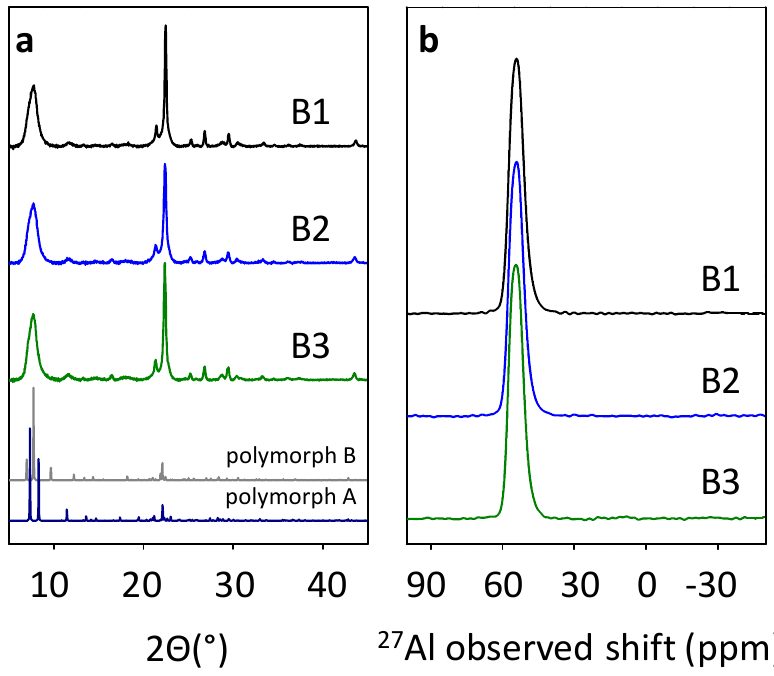
Figure 1. X-ray di ff raction patterns of as-synthesized B1–B3 samples together with *BEA polymorphs Figure 1. X ‐ ray diffraction patterns of as ‐ synthesized B1–B3 samples together with *BEA polymorphs A and B ( a ) and 27 Al MAS NMR spectra of as-synthesized B1-B3 samples ( b A and B ( a ) and 27 Al MAS NMR spectra of as ‐ synthesized B1 ‐ B3 samples ( b ).